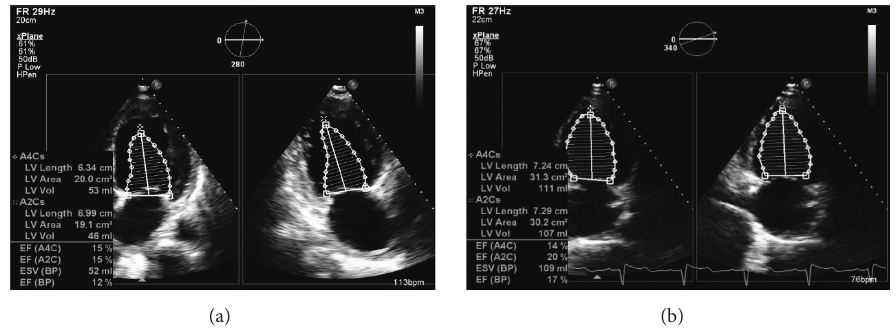
Figure 2: Echocardiography demonstrating decreased ejection fraction on admission (a) and two months later (b).